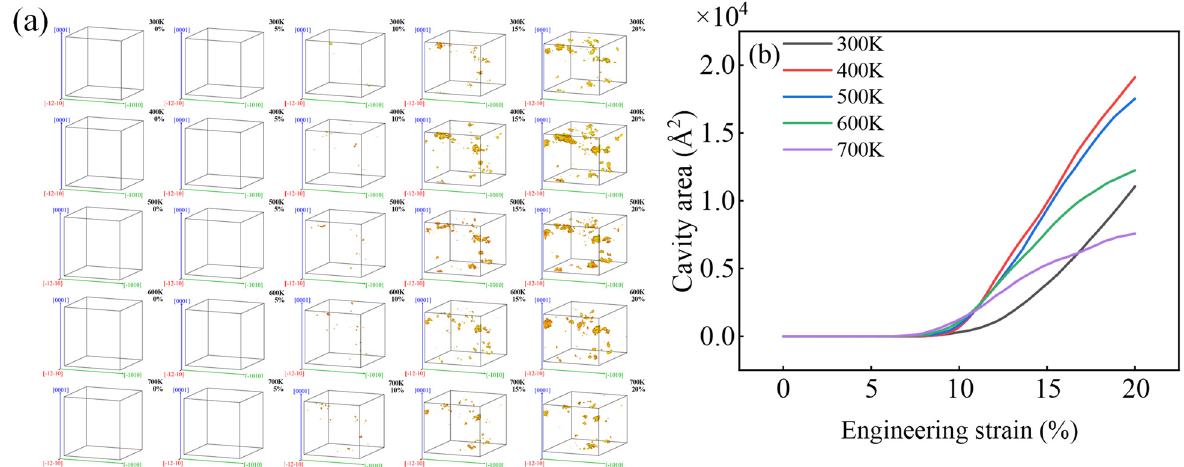
Figure 12: Cavity evolution: ( a ) cavity diagram and ( b ) cavity curve.